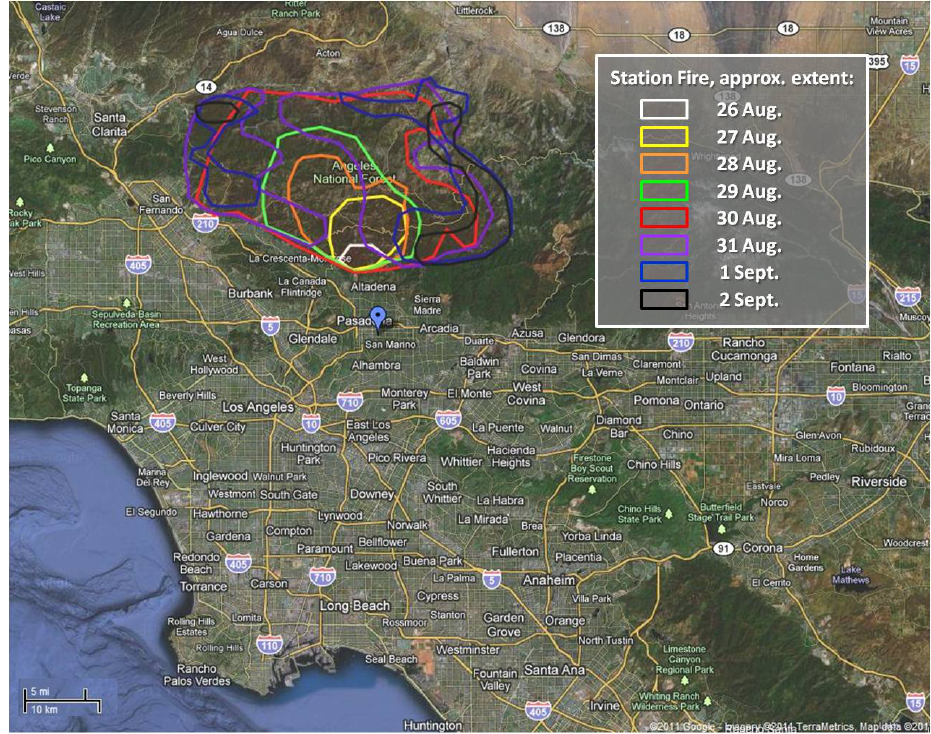
Fig. 1. Approximate spatial extent of the Station Fire by date (bordered areas). The fire area was estimated using fire maps by “Firefly” (University of Maryland; http://firefly.geog.umd.edu/firemap/). The blue marker in Pasadena represents the measurement site.